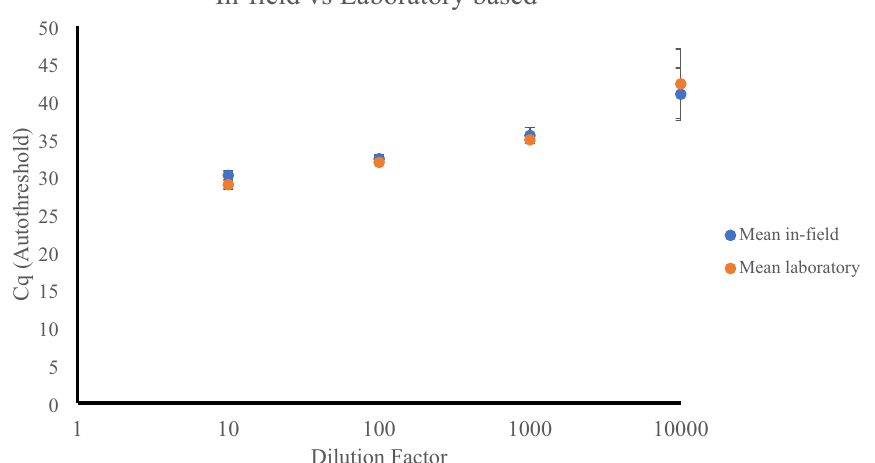
Figure 3. A comparison of in-field Biomeme M1 Bulk RNA Kit (blue) and laboratory based nucleic acid extraction kit (Invitrogen PureLink RNA/DNA extraction kit) (orange) for the recovery of AIV RNA in environmental faecal samples. Mean Cq values from three replicates tested in the AIV RT-PCR assay is shown (total number of samples = 30, three samples per dilution per kit). Error bars represent the standard deviation of experimentation run in triplicate.